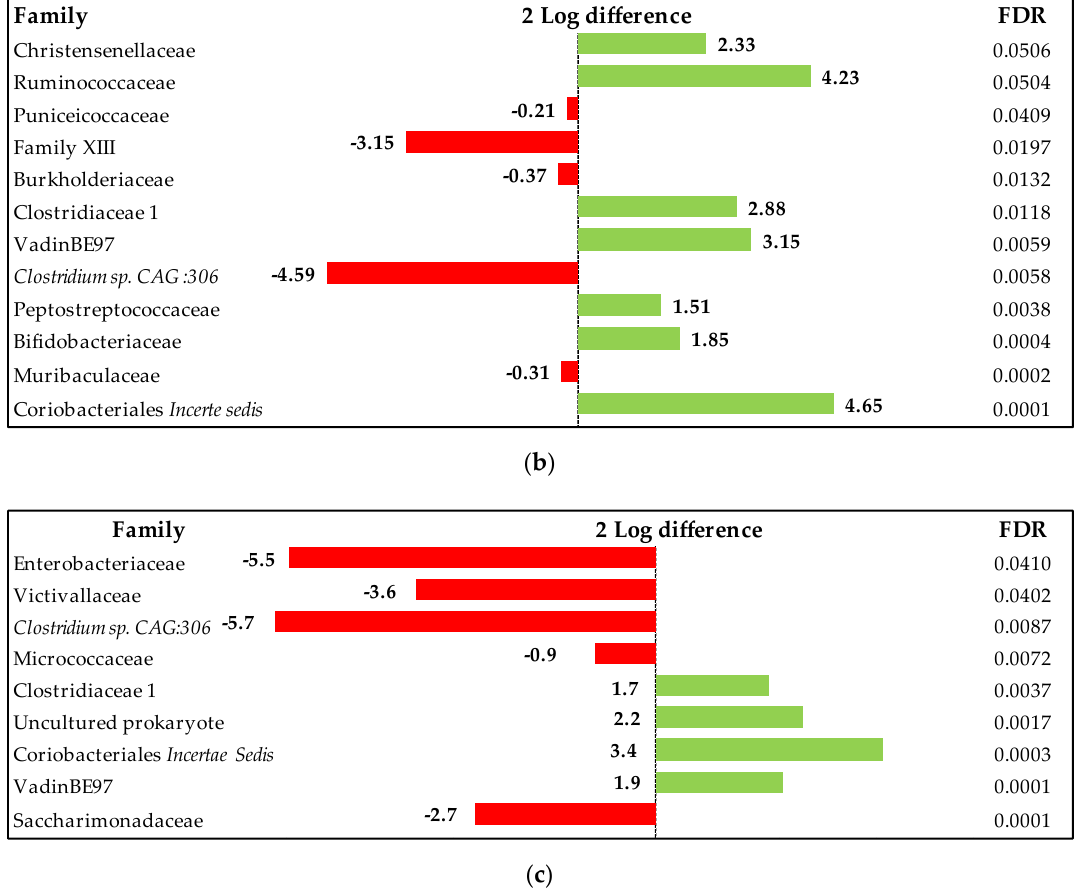
Figure 8. Differentially abundant taxa (family) from the cecum (in change and FDR-adjusted, p ≤ 0.05) on d 42 between OA3 + MCFA + AC vs. NC ( a ), OA2 + AC vs. NC ( b ), and NC vs. PC ( c ). OA2: Calcium butyrate + fumaric acid; OA3: Calcium butyrate + fumaric acid + citric acid + MCFA; MCFA: Capric-caprylic acid + caproic acid + lauric acid; AC: Cinnamaldehyde, carvacrol, and thymol as major compounds.